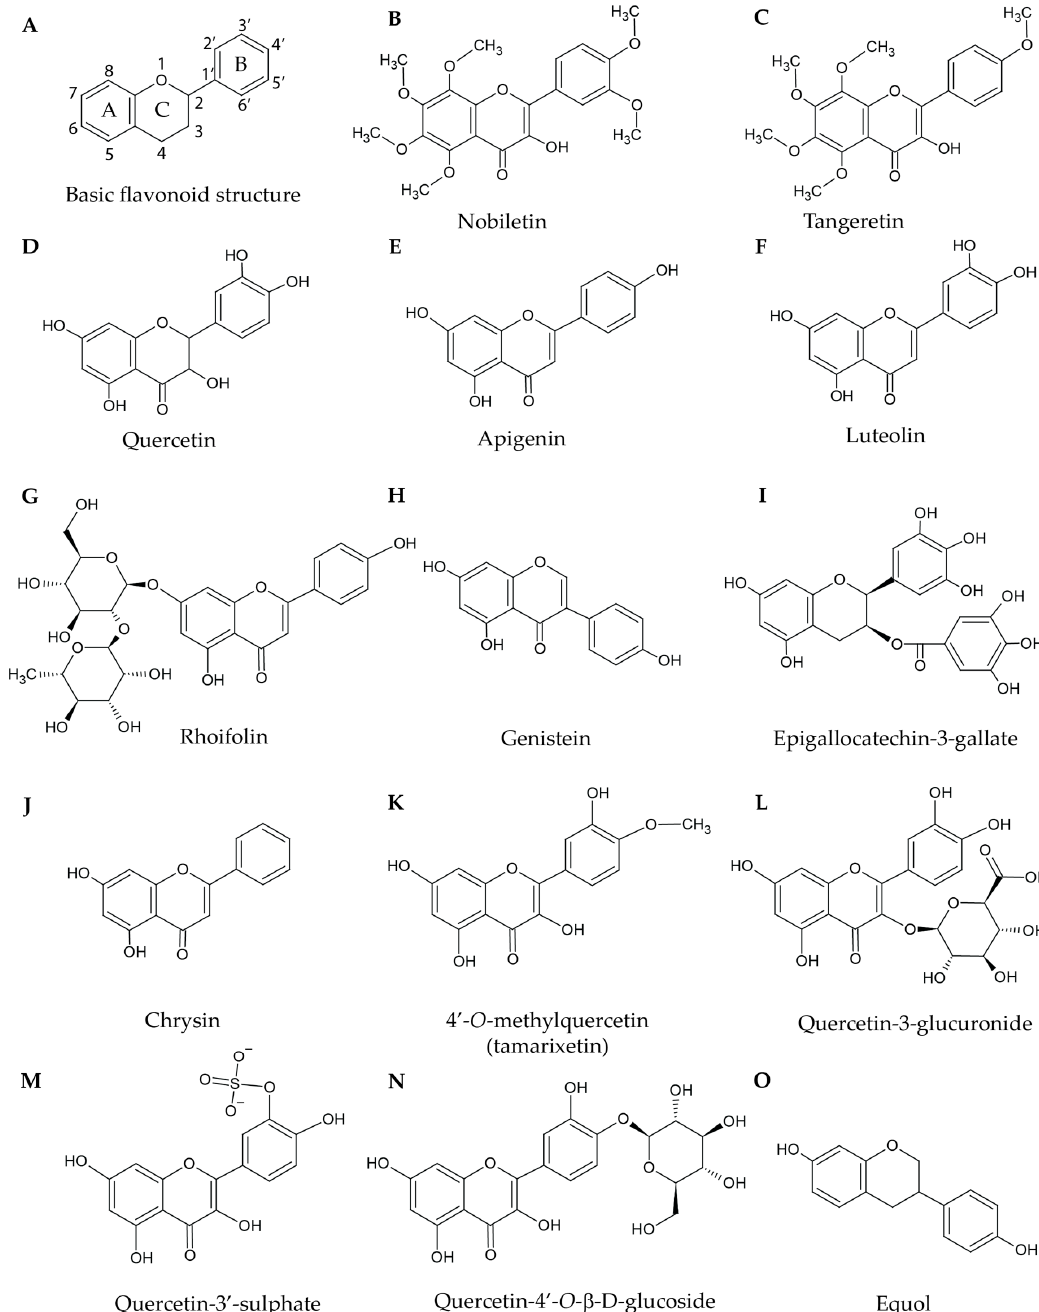
Figure 1. Structures of selected natural flavonoids and metabolites: ( A ) The basic structure of flavonoids. A, B, and C denote the A-ring, B-ring, and C-ring respectively. Nobiletin ( B ) and tangeretin ( C ) are both heavily methoxylated. Quercetin ( D ), apigenin ( E ), and luteolin ( F ) possess similar structures but differ in the extent of their hydroxylation. Rhoifolin ( G ) is a flavonoid with a glycoside bond at C7 on the A-ring. Genistein ( H ) has a simple structure similar to apigenin; however, the B-ring is connected at C3 rather than C2. Epigallocatechin-3-gallate ( I ) possesses an ester bond connecting the phenyl ring to the flavonoid core. Chrysin ( J ) is a very simple flavonoid with no hydroxyl groups attached to the phenyl B-ring. 4 ′ - O -methylquercetin ( K ), quercetin-3-glucuronide ( L ), and quercetin-3 ′ -sulphate ( M ) are metabolites of quercetin and are either methylated, glucuronidated, or sulphated, respectively. Quercetin-4 ′ - O - β -D-glucoside ( N ) has a glucosidic bond at the 4 ′ position. Equol ( O ) is a metabolite that is produced by gut bacteria.